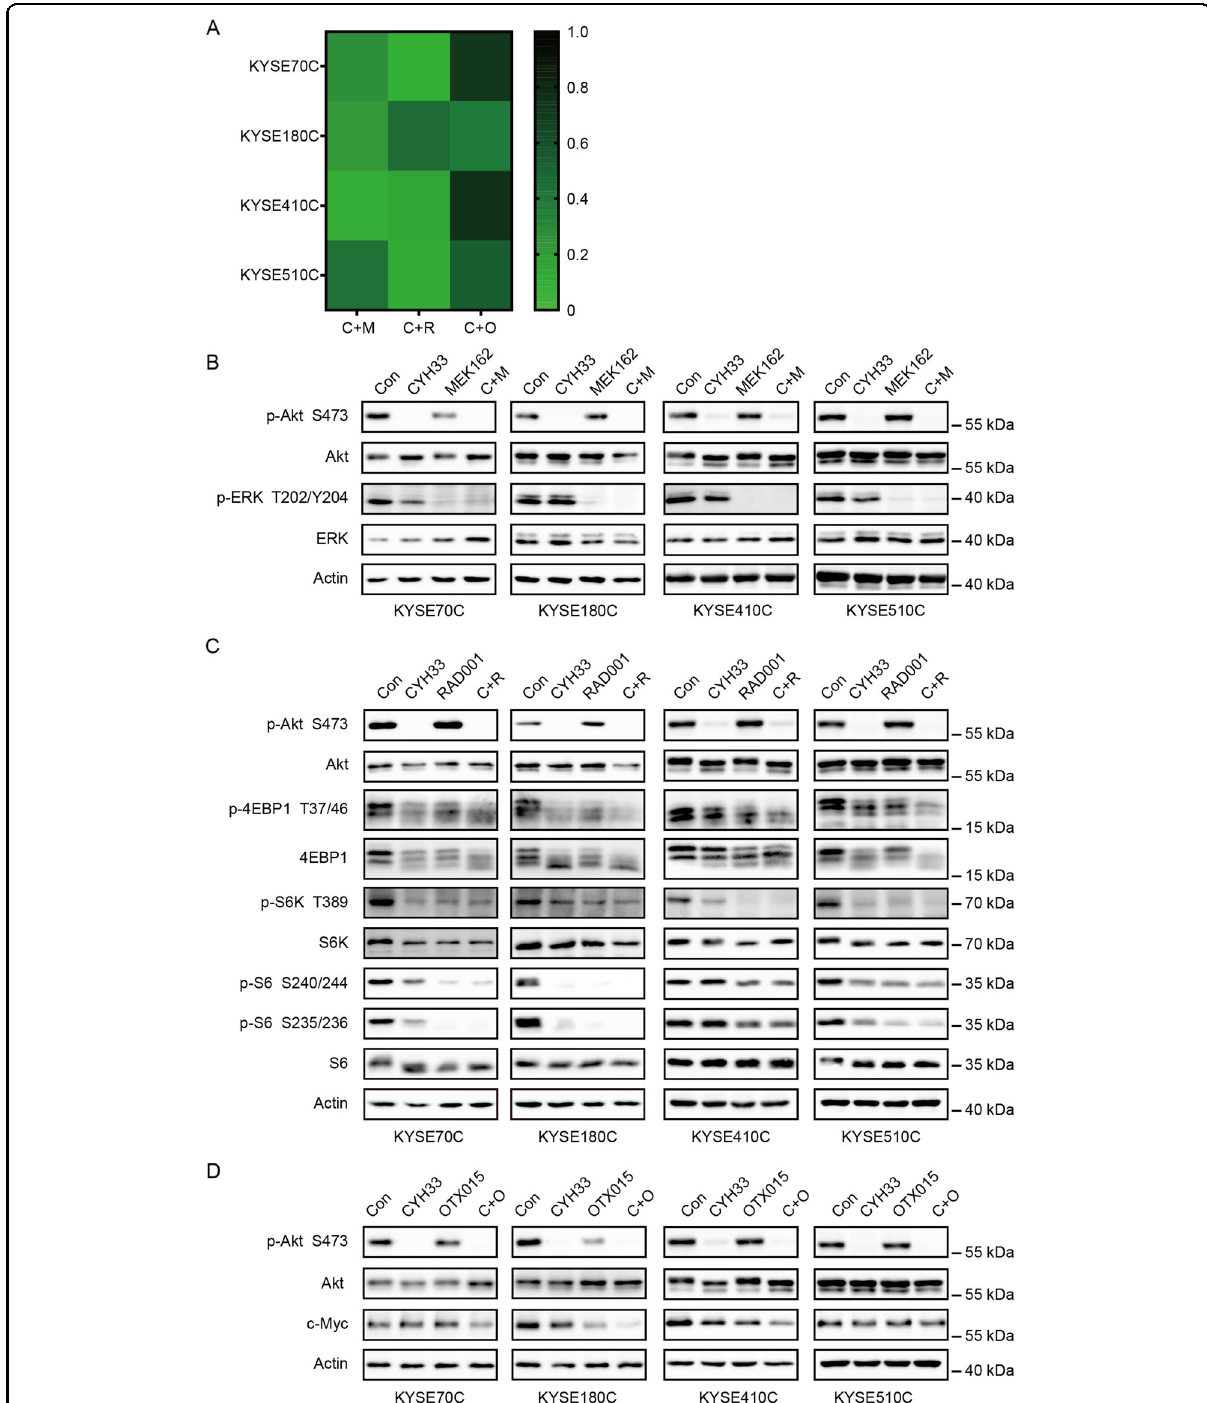
Fig. 6 Combination of CYH33 with MEK/mTORC1/BET inhibitors synergistically suppressed growth of CYH33-resistant cells. A CYH33- resistant cells were treated with MEK162/RAD001/OTX015 and CYH33 alone or in combination for 72 h. Cell proliferation was measured with SRB assay and combination index (CI) values were calculated by Calcu Syn software ( n = 3). B – D CYH33-resistant cells were treated with CYH33 (1 μ M, blotting with indicated antibodies. Data shown are from at least two independent experiments. C: CYH33, M: MEK162, R: RAD001, O: